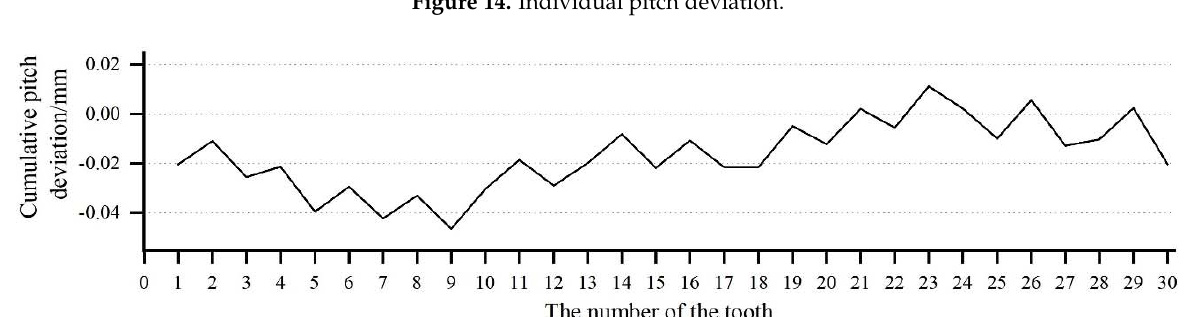
Figure 14. Individual pitch deviation.